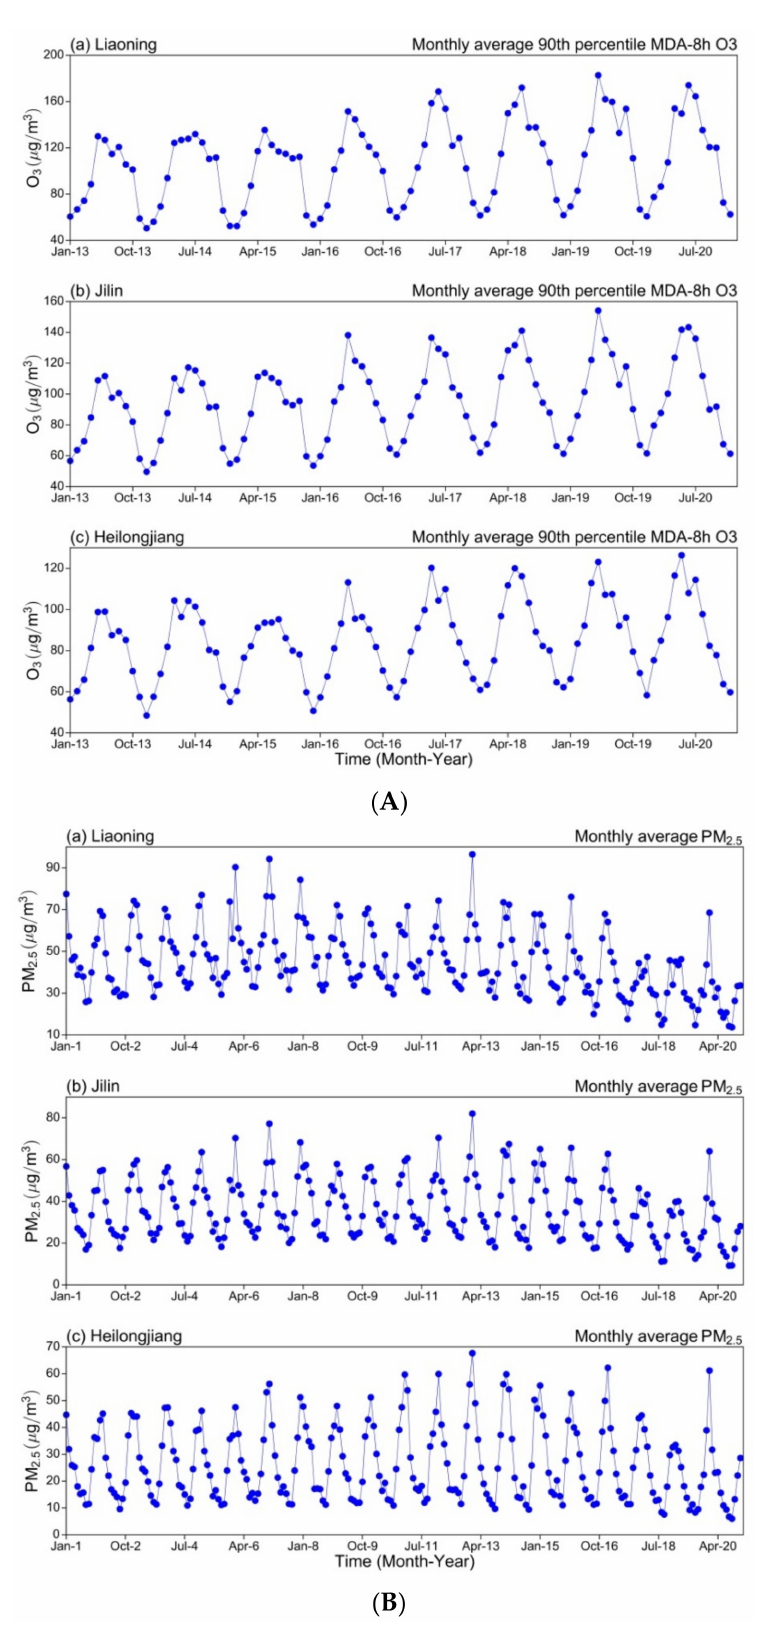
Figure 6. Interannual trend of mean monthly concentrations of ( A ) O 3 -8h-90per from 2013–2020 and ( B ) PM 2.5 from 2001–2020 in ( a ) Liaoning, ( b ) Jilin and ( c ) Heilongjiang province over